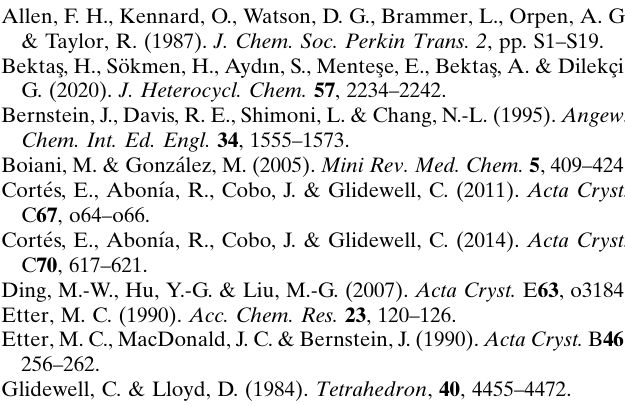
Table 2 Experimental details. Crystal data Chemical